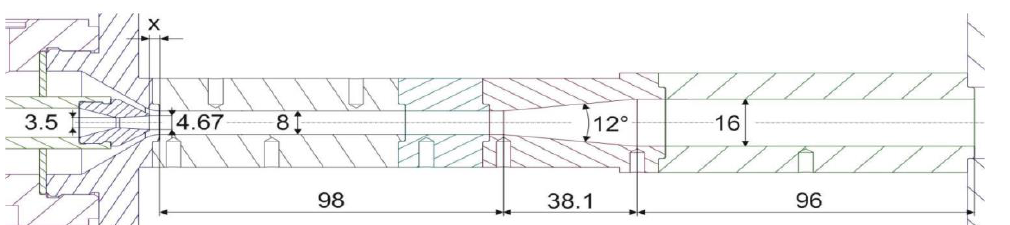
Fig. 1. : ejector geometry (dimensions in mm) [8]